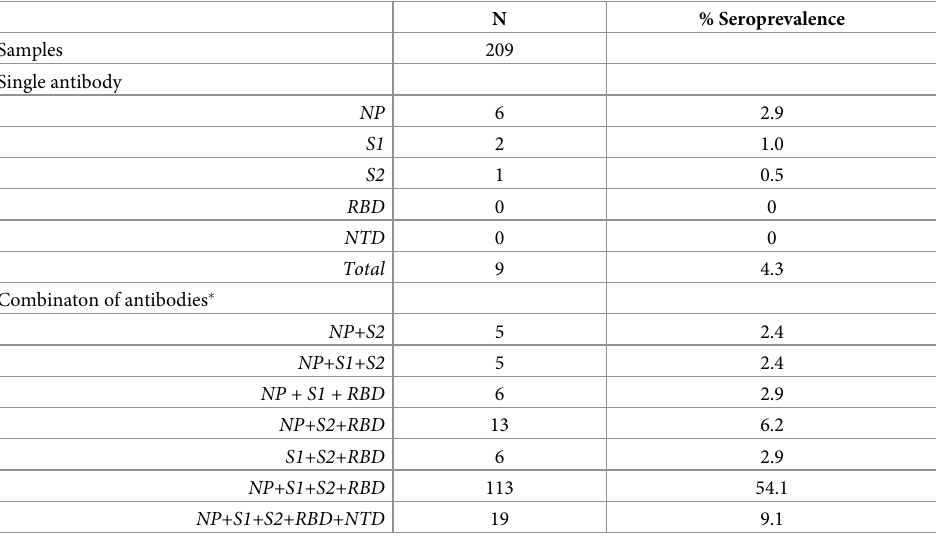
� For clarity purpose, only most common combinations with > 2% seroprevalence are